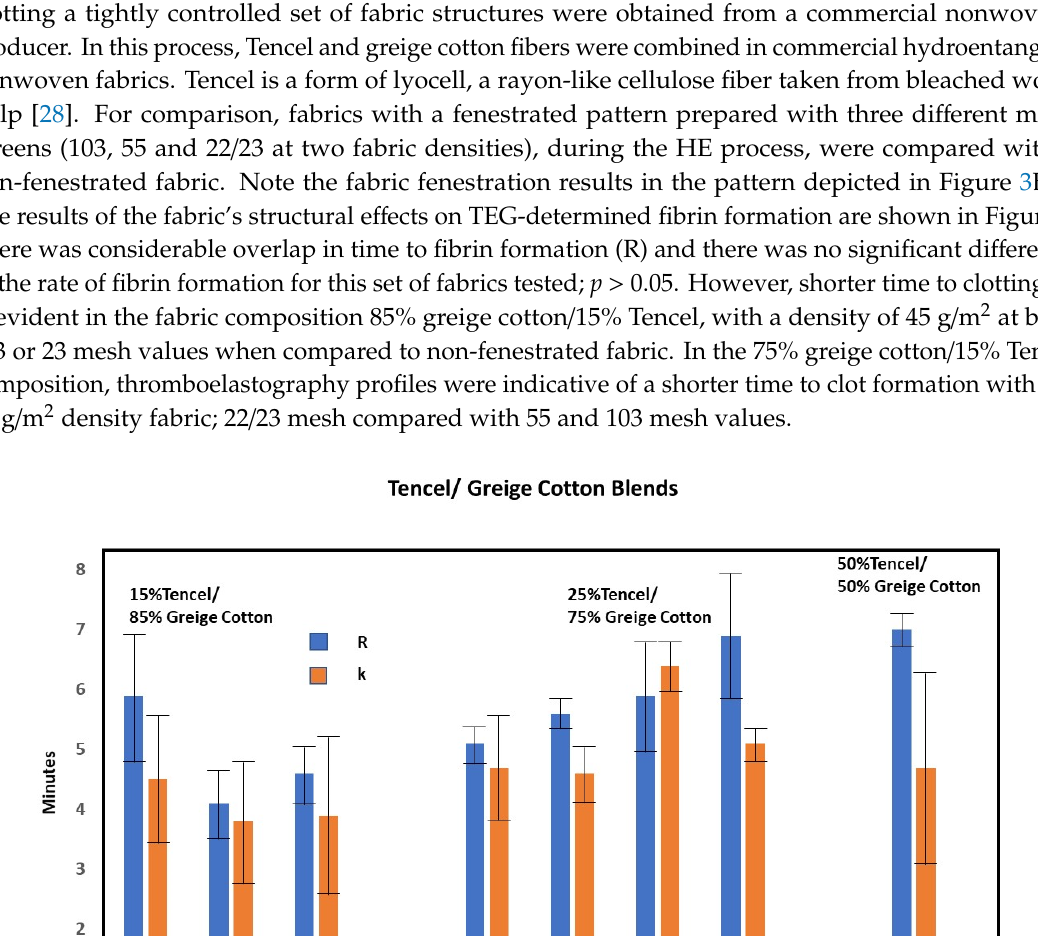
Figure 5. Diagram of a nonwoven hydroentanglement line. An outline schematic of the Fleissner MiniJet system used in the study.